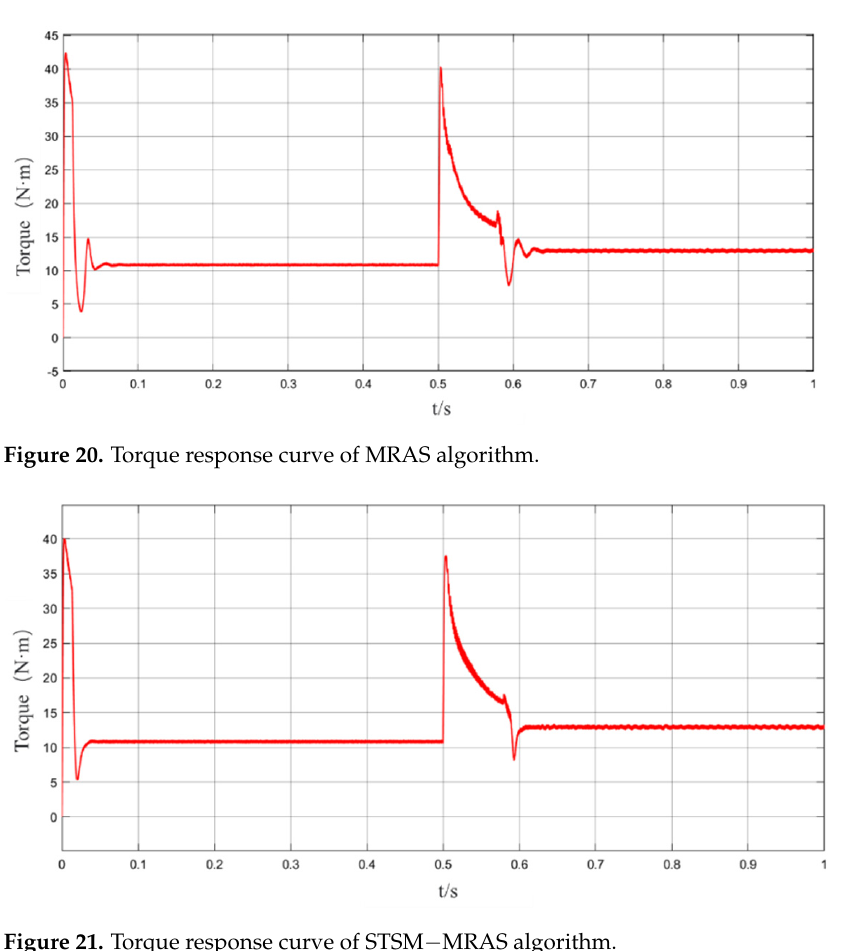
Figure 19. Speed response curve of STSM − MRAS algorithm.